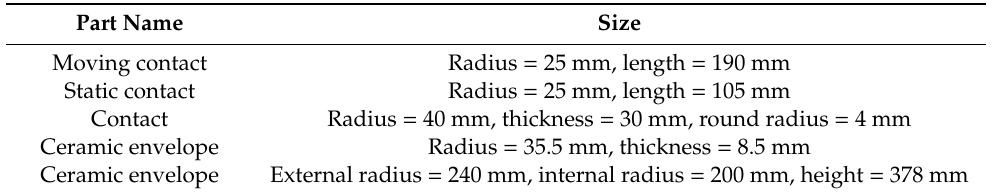
Table 2. Parameters of the 40.5 kV VCB.